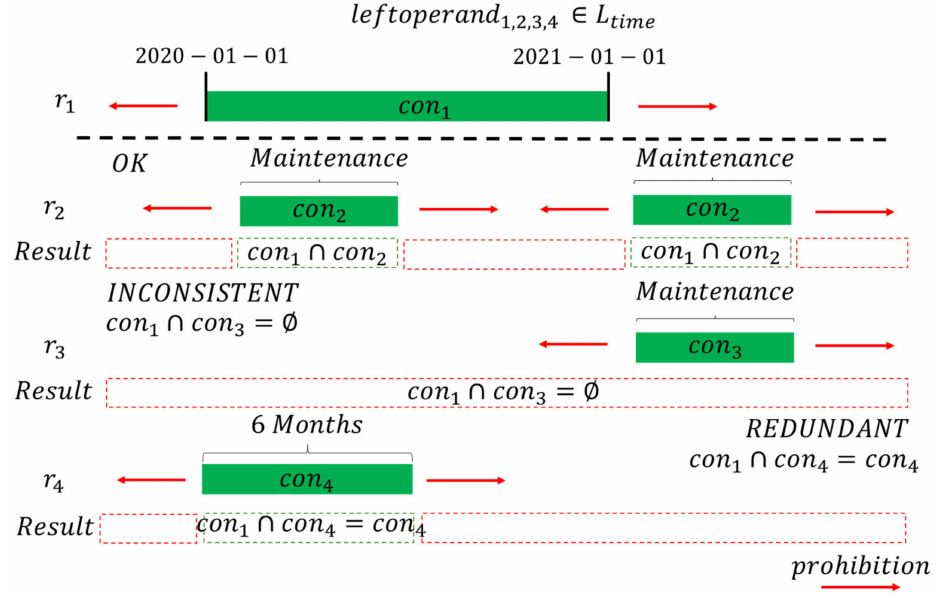
Figure 3. Common Resource Conflict Detection. Whitelisting